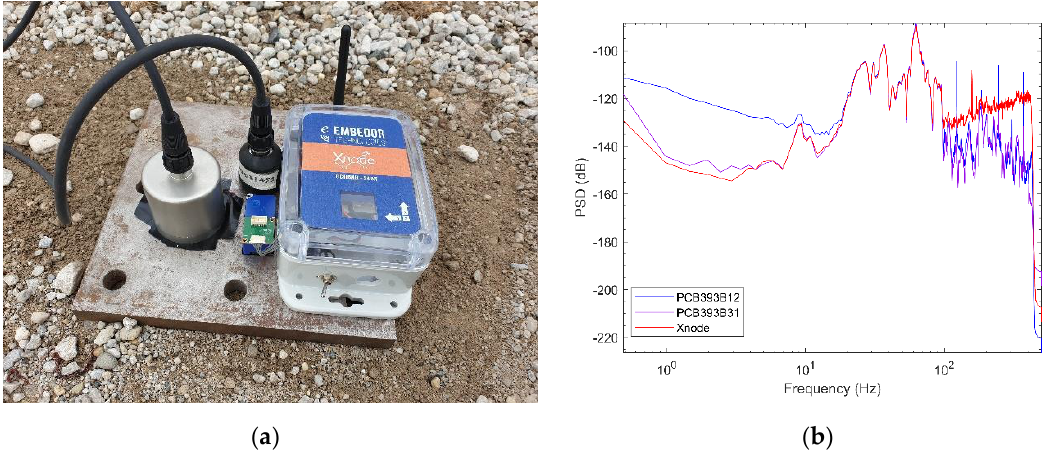
Figure 12. Field ambient vibration test results: ( a ) test setup using Xnode—M-A352 with two reference sensors ( b ) PSD plot of acceleration records.